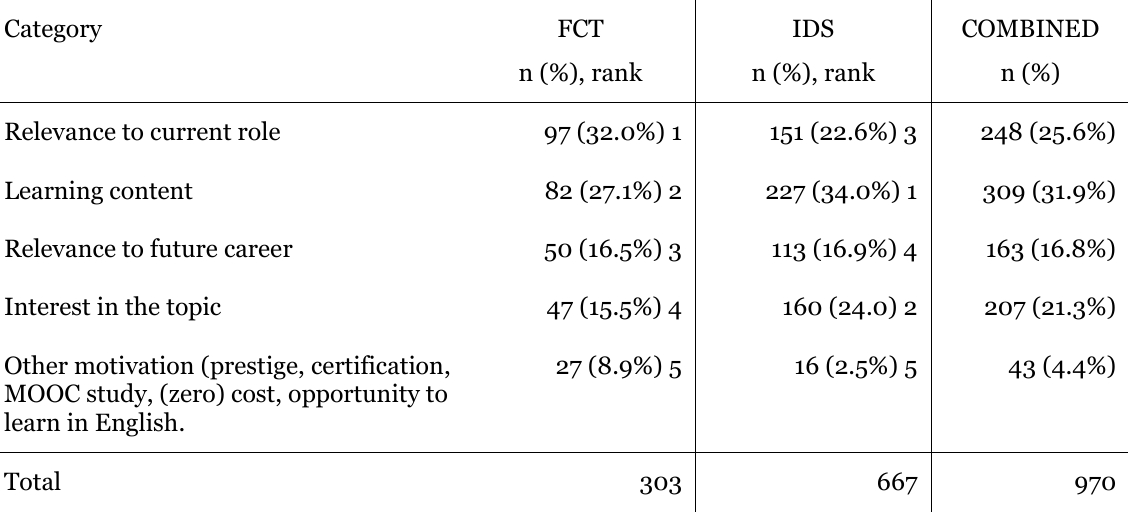
MOOC Participant